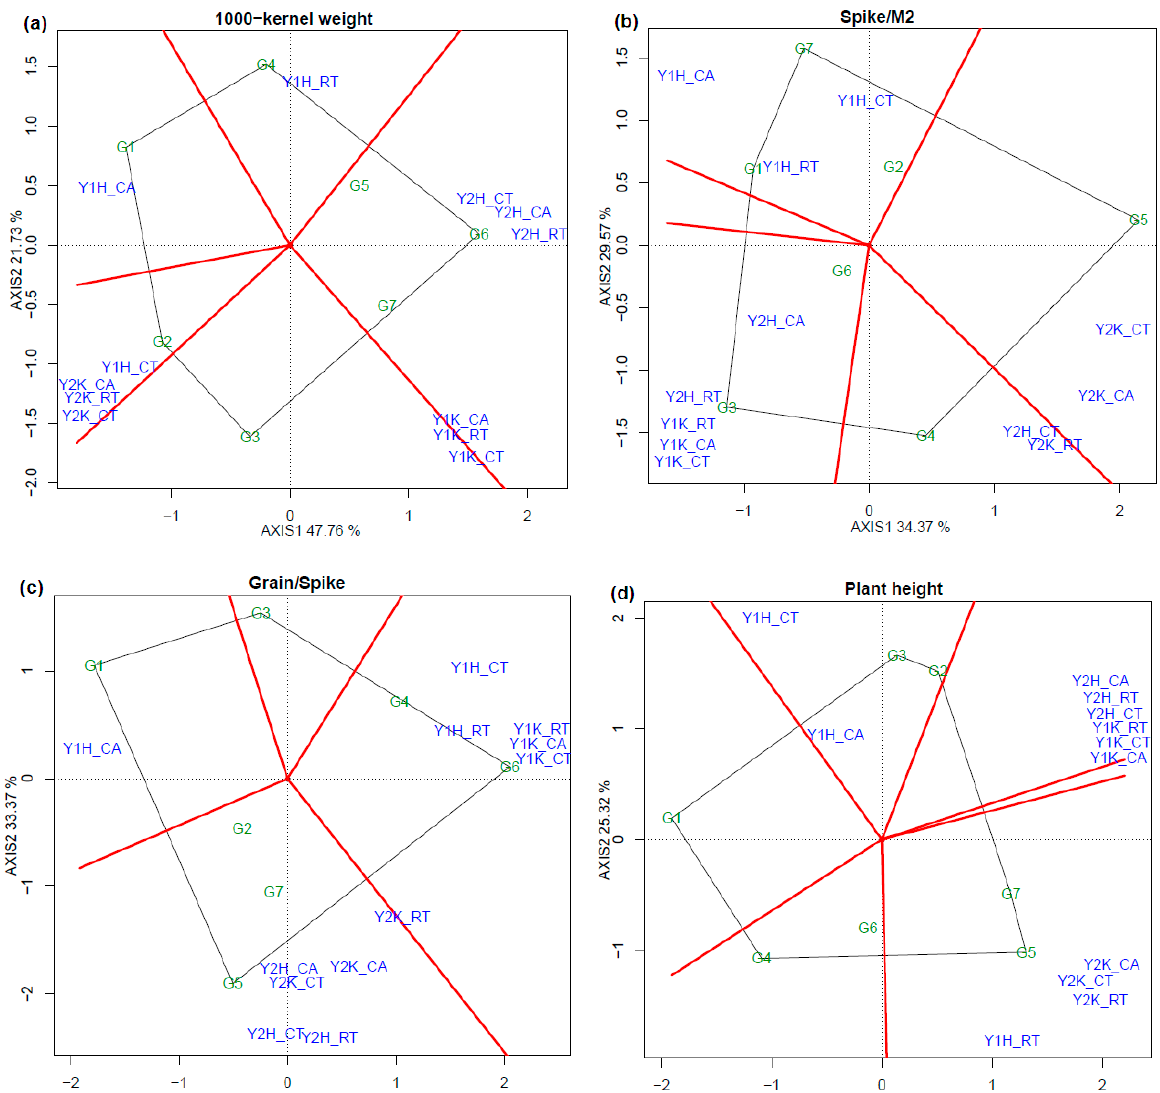
Figure 4. “Which-wins-where” pattern of GGE biplot for ( a ) 1000-kernel weight, ( b ) spikes/m 2 ( c ) grains/spike and ( d ) plant height of seven barley genotypes (G1–G7) across 12 environments.